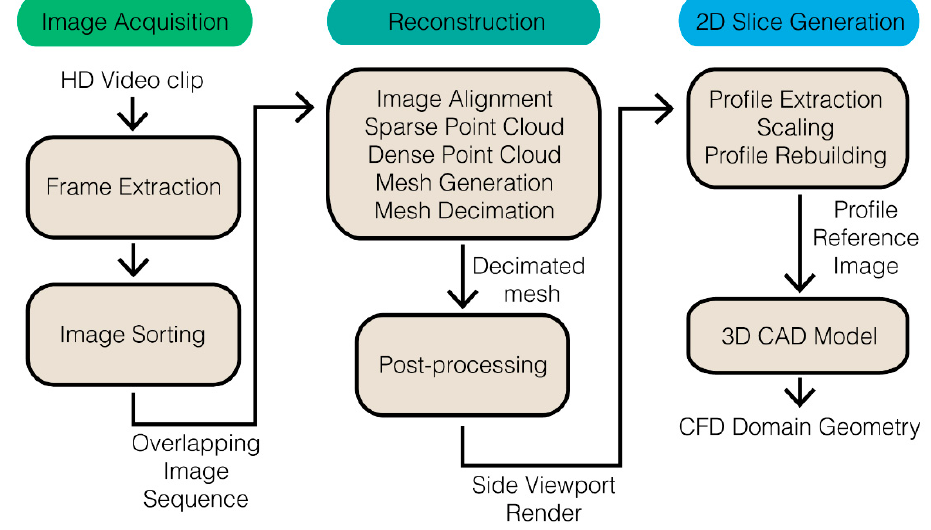
Figure 3. Summary of the workflow used in this study for reconstruction of the nest and creation of the CFD meshes.